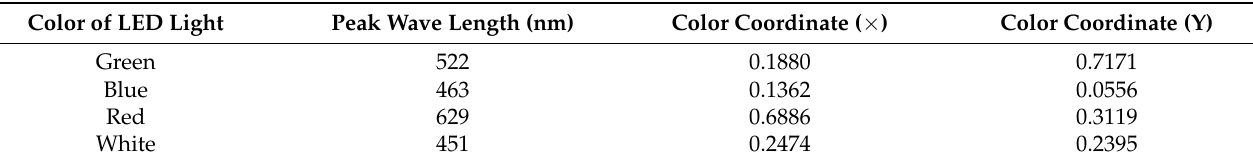
Table 1. Specifications of LED lights used for the experiments.